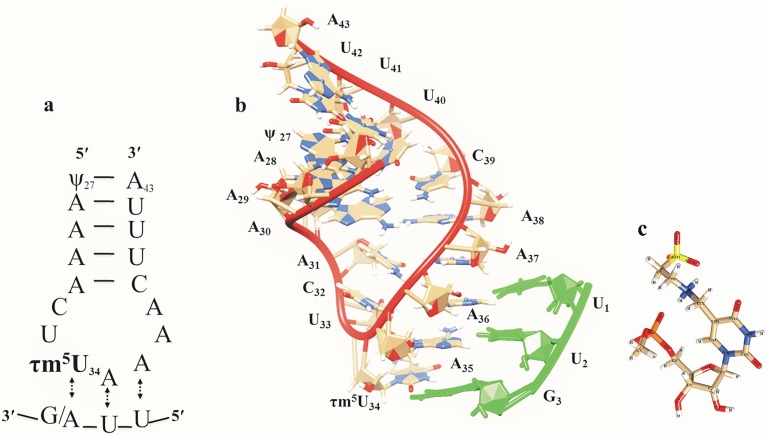
Model anticodon stem loop (ASL) with codon ‘UUG/A’ in a) the clover leaf model and b) three-dimensional structure of ASL of tRNALeu considered for MD simulation c) modification τm5U with nomenclature.